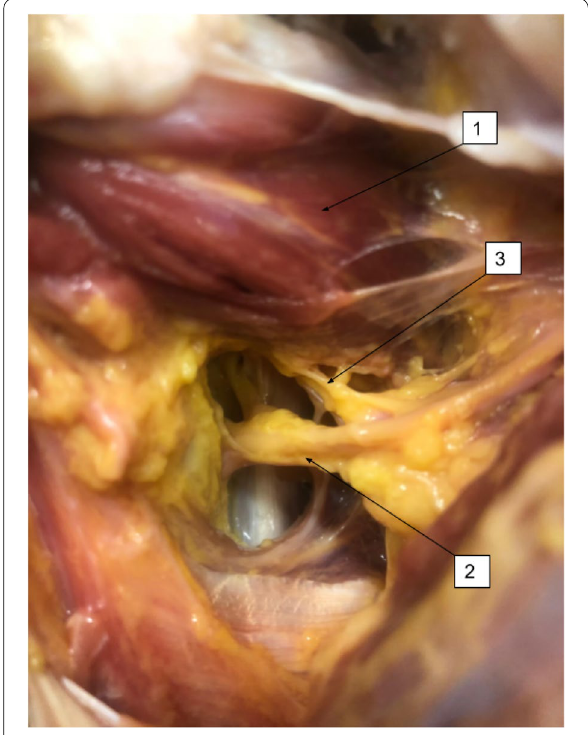
Fig. 2 Delto-pectroal approach. (1) Subscapularis muscle; (2) Axillary nerve; (3) Articular branch of the axillary